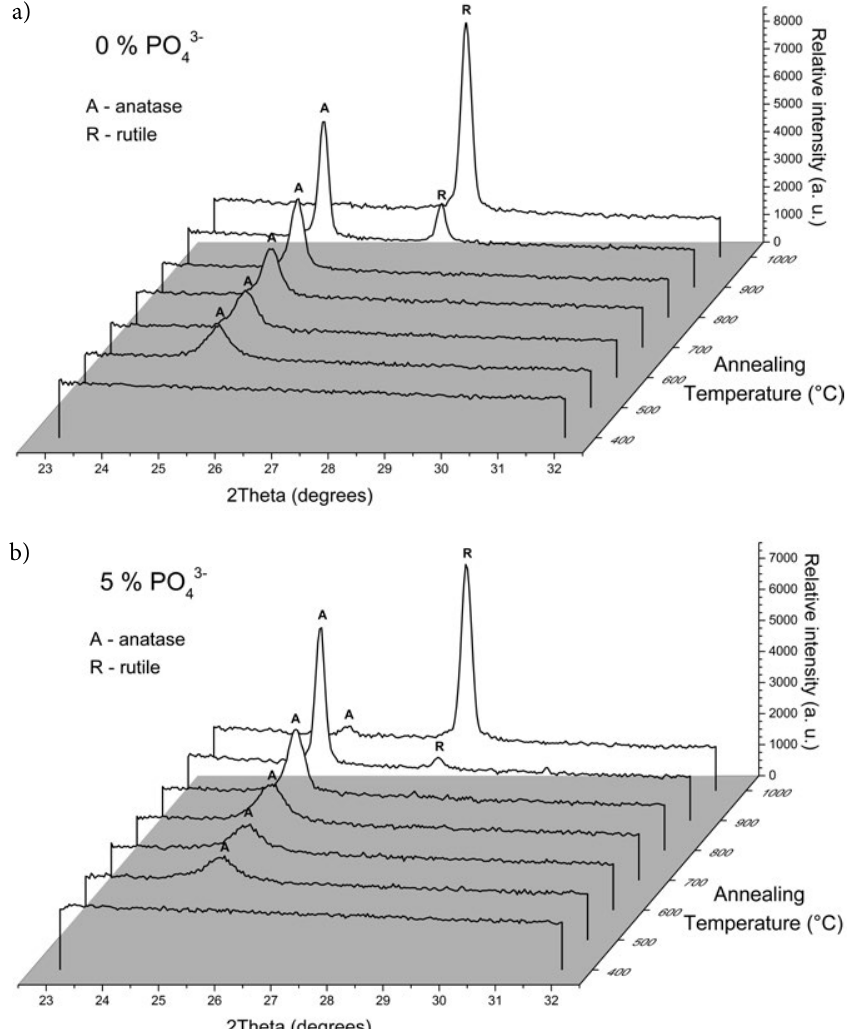
thin films, b: TiO thin films 2 2